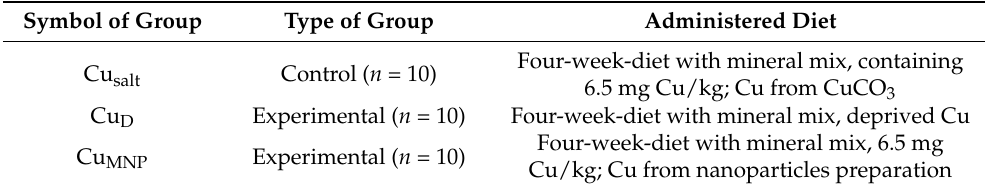
Table 3. The experimental scheme of applied copper. Symbol of Group Type of Group Administered Diet Four-week-diet with mineral mix, containing Cu salt Control ( n = 10) 6.5 mg Cu/kg; Cu from CuCO 3 Cu D Experimental ( n = 10) Four-week-diet with mineral mix, deprived Cu Four-week-diet with mineral mix, 6.5 mg Cu MNP Experimental ( n = 10) Cu/kg; Cu from nanoparticles